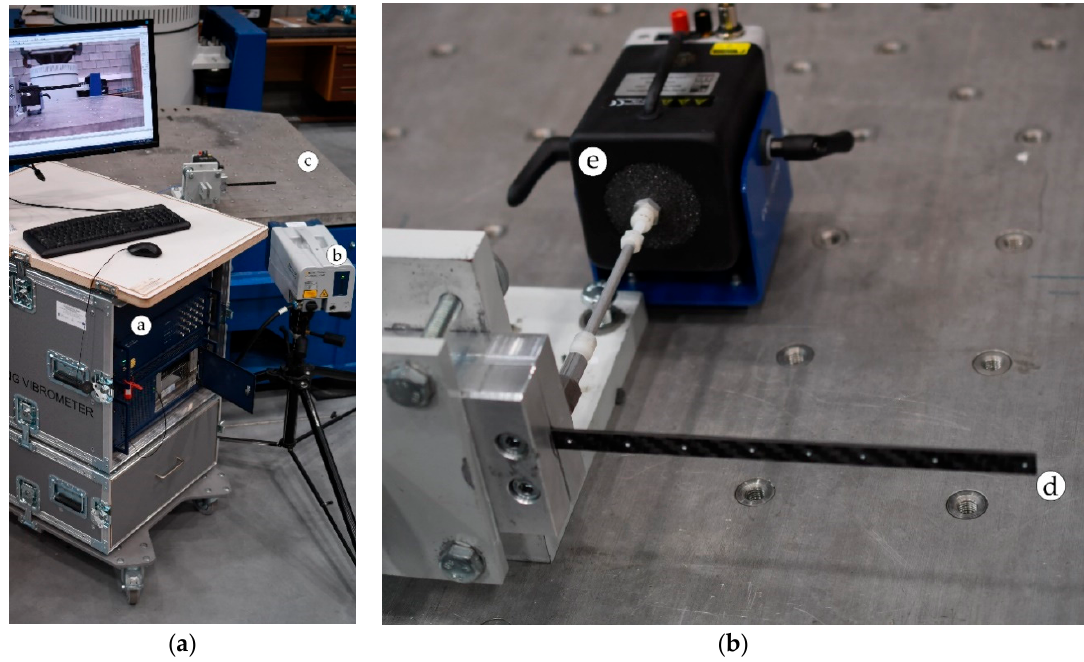
Figure 6. Experimental setup for the laser vibrometer tests: ( a ) view of the setup of the laser vibrometer PSV-500 camera system and ( b ) dedicated grip with the specimen (close-up view). Parts of the setup: a—mobile workstation, b—PSV scanning head, c—anti-vibrational table, d—specimen, and e—electrodynamic shaker.